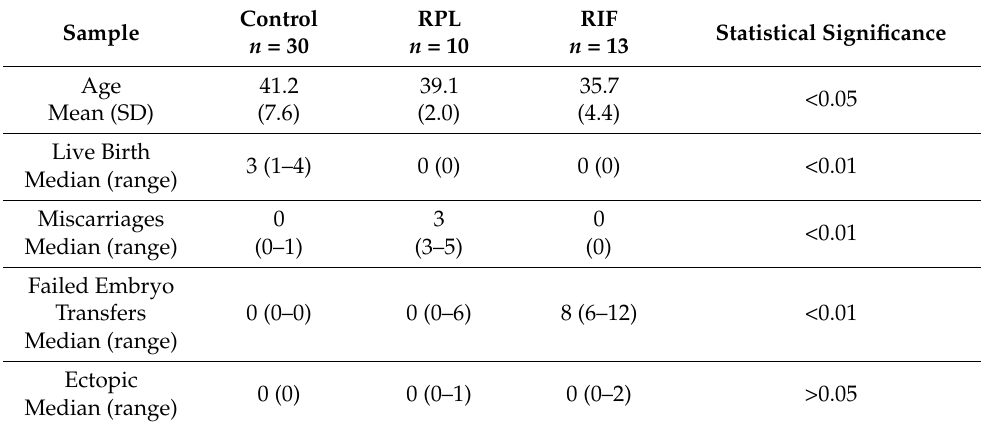
Table 2. Demographics, cohort